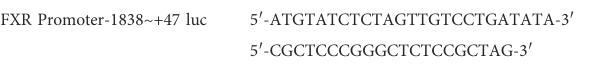
TABLE 2 Primers used in plasmids